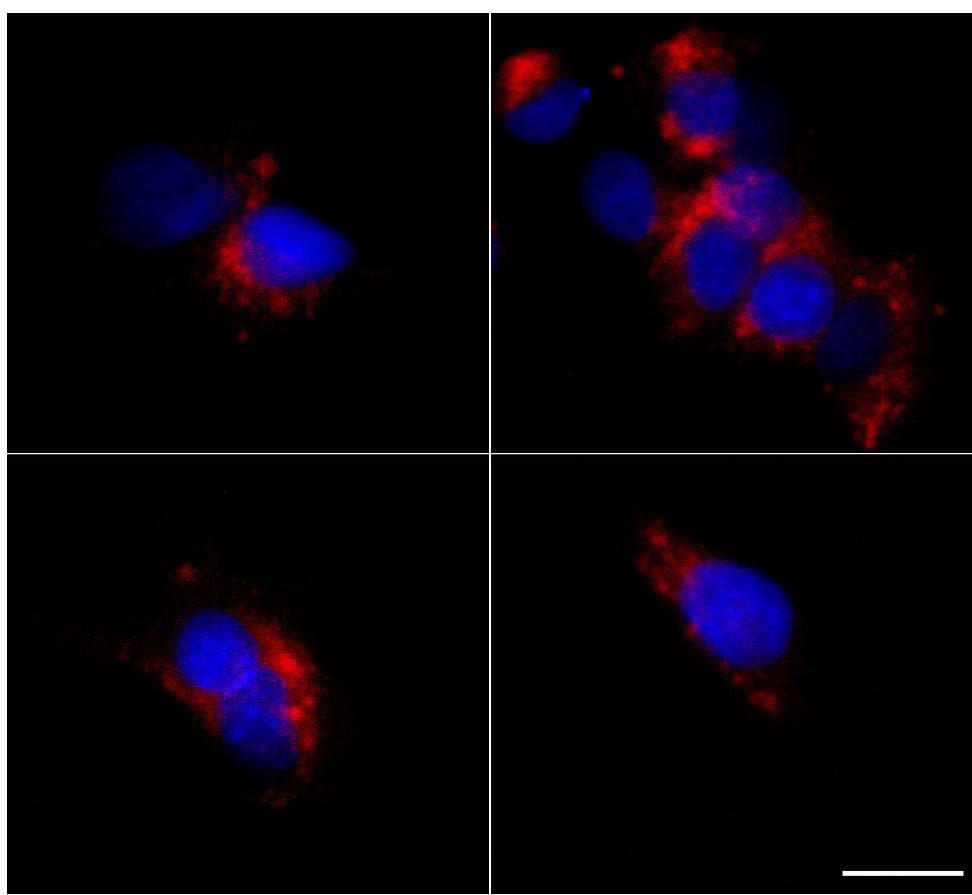
Figure 7. Fluorescence microscopy images of intracellular disposition of the Nile Red-labeled GM-SLN vector 2 h after the addition to Hep G2 cells. Images correspond to different cells of four replicates. Blue: nuclei labeled with DAPI. Red: fluorescence signal of GM-SLN vector prepared with Nile Red-labeled SLNs. Magnification: 60×. Scale bar: 15 µm.